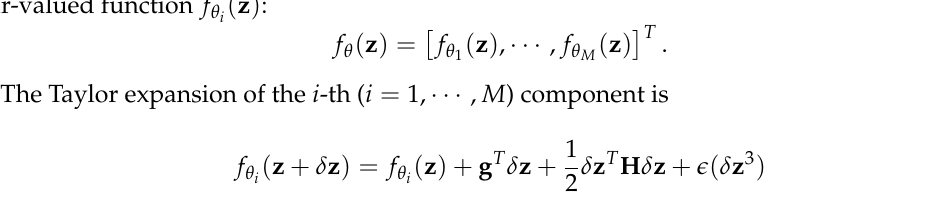
Figure 1. Diagram of the proposed method. The variational noise z v (P-1)-th